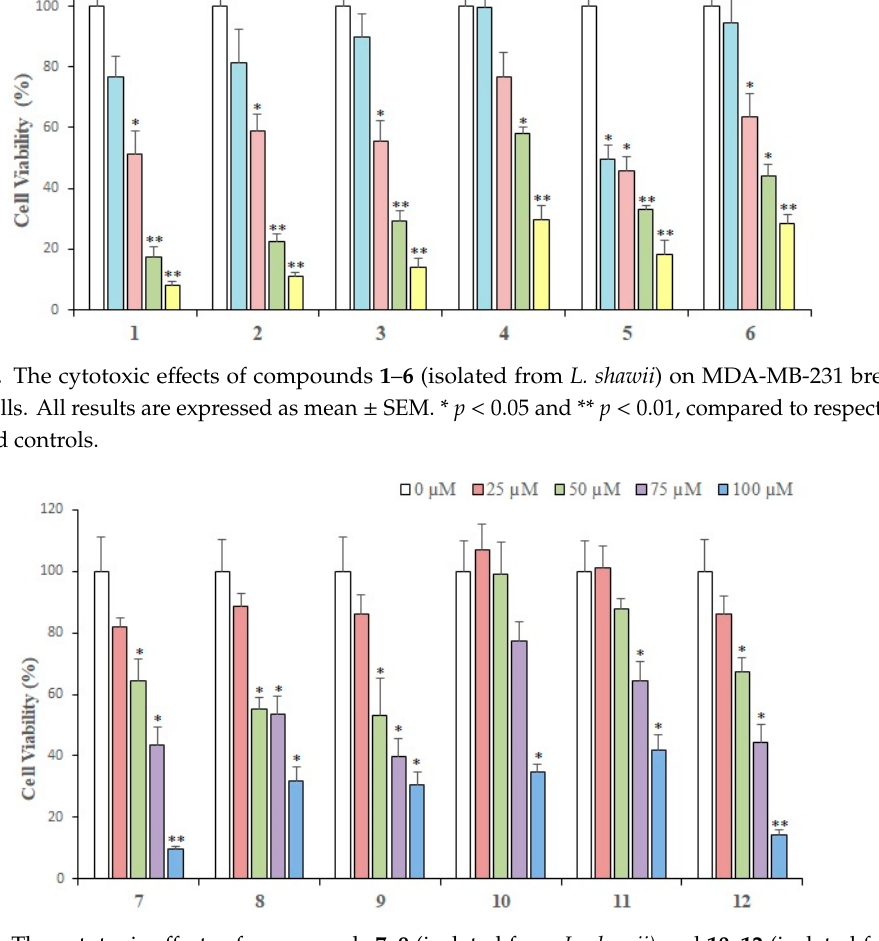
Figure 3. The cytotoxic e ff ects of compounds 7 – 9 (isolated from L. shawii) and 10 – 12 (isolated from A. vera ) on MDA-MB-231 breast cancer cells. All results are expressed as mean ± SEM. * p < 0.05 and ** p < 0.01, compared to respective untreated